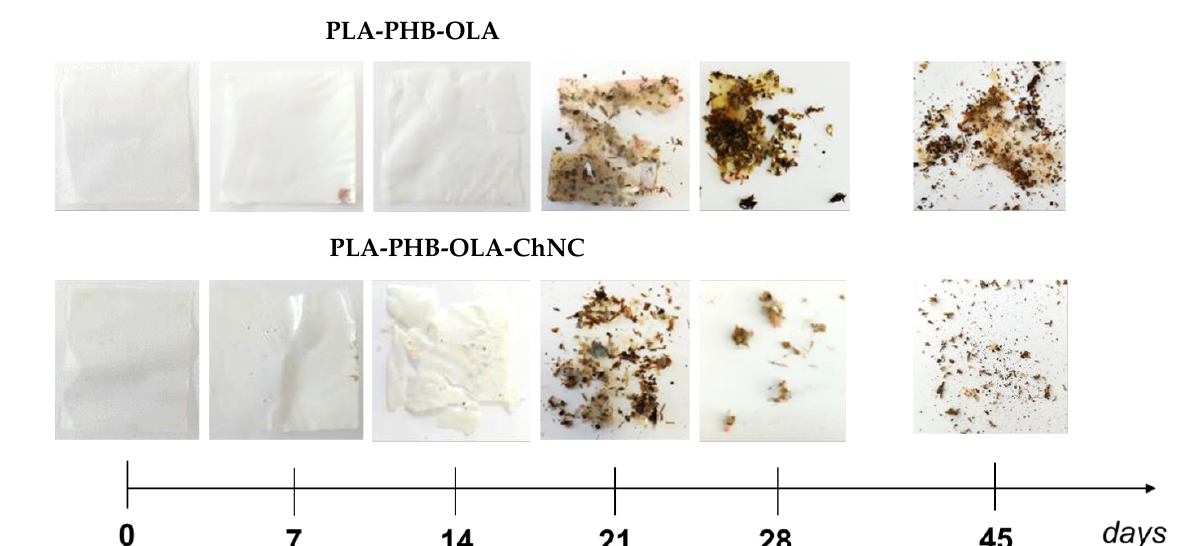
Figure 4. Disintegration of produced nanocomposites under composting conditions: pictures of specimens at different test days.